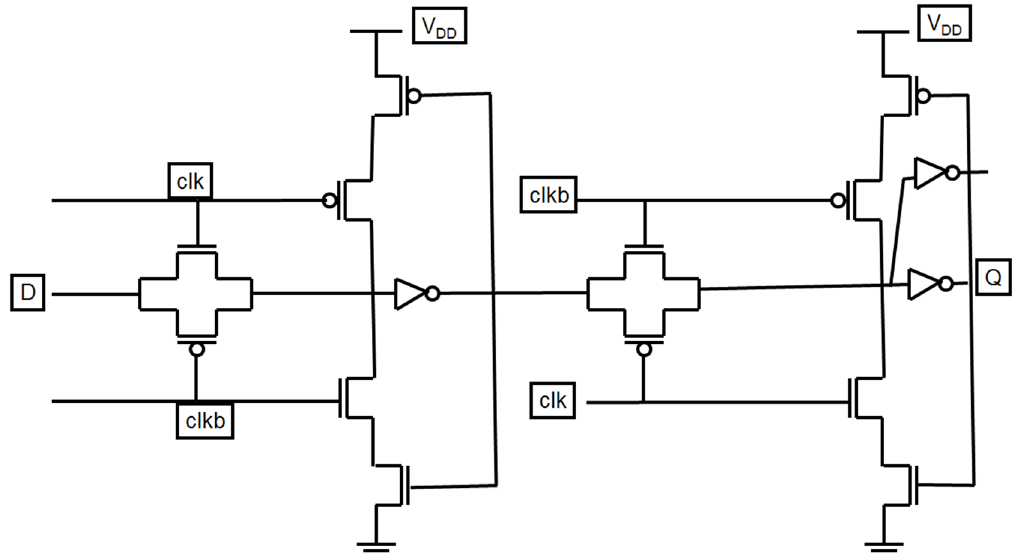
Figure 7. Schematic of the PowerPC 603 master–slave latch.